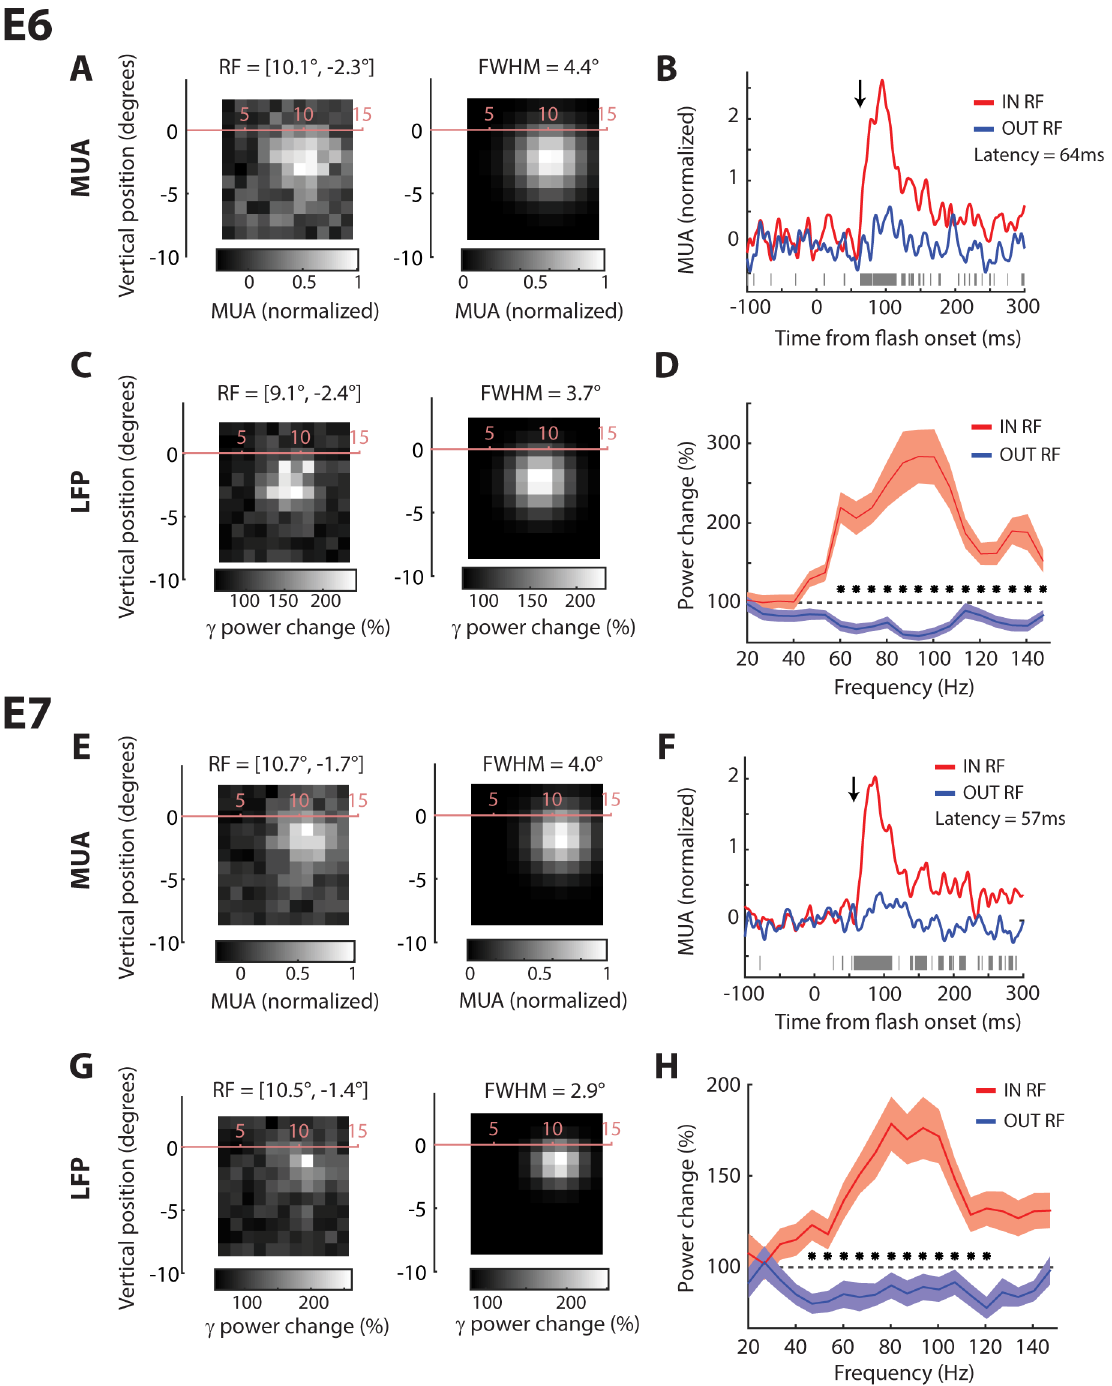
Fig 2. Receptive field location and size estimates from E6 and E7. (A) MUA receptive field (activity averaged between 50 and 300 ms after stimulus onset) from E6 to a 1° x 1° checkerboard briefly presented at each location of an 11 x 11 grid (left panel). The center of the RF was estimated by fitting a 2D Gaussian (right panel) to the data and the RF size as the width of the Gaussian at half of the maximum (FWHM), averaged across the x and y directions. (B) Responses from the 10% of locations closest to the center of the RF (red line) and the 10% of locations farthest from the center of the RF (blue line). The gray bars indicate samples with significant differences between these conditions ( t test, p < 0.05). The latency of the response was estimated as the first significant sample that was followed by ten contiguous significant tests (arrow). (C) The change in gamma power (40 – 120 Hz) in a window from 100 – 250 ms after stimulus onset at each stimulus location relative to the average power across all locations (left panel). We also fit a 2D Gaussian to the spatial profile of the gamma power increase (right panel). (D) The relative increase in power when a flash was presented within the RF (10% closest locations, red